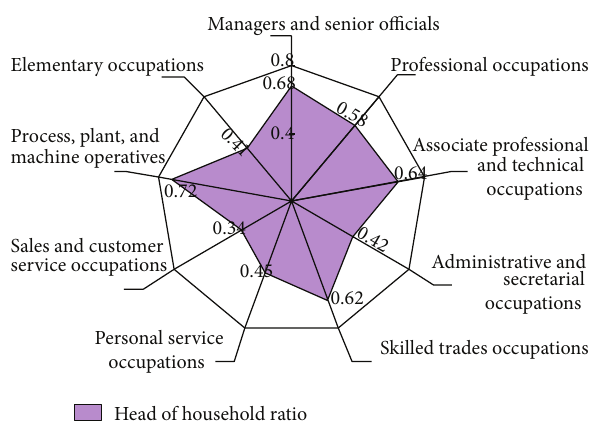
Figure 5: Estimated household headship by occupations, based on Labour Force Survey 2005 [17].